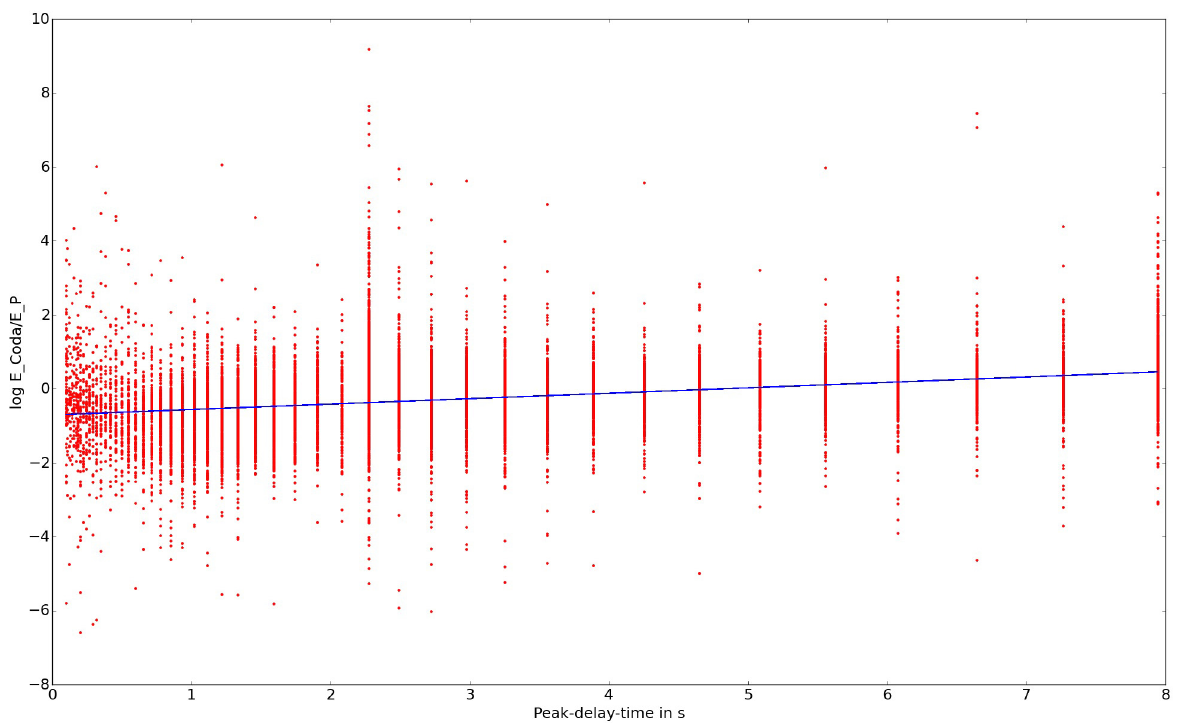
Figure 7. The energy ratio plotted over the peak delay time. There is a clear correlation between these two parameters.